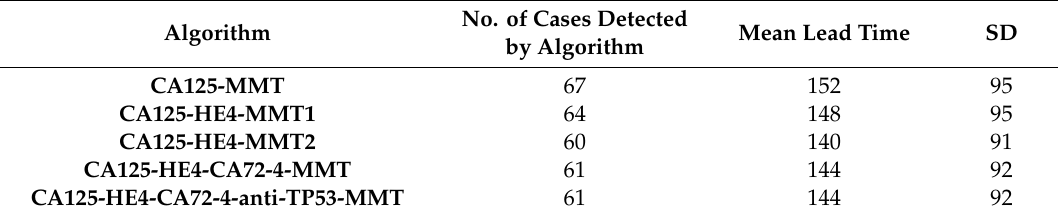
Table 4. Lead time of algorithms for the detection of invasive tubo-ovarian cancer in the validation set.